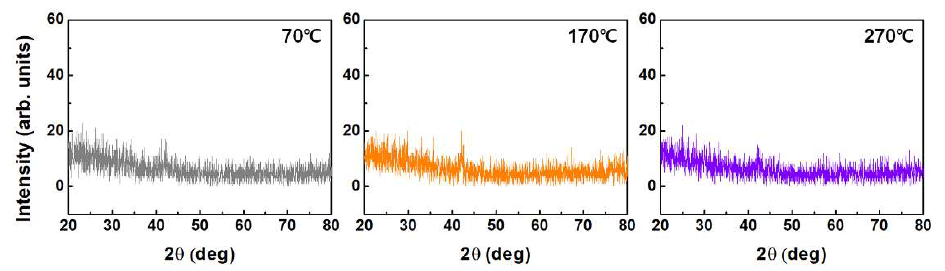
Figure 9. XRD graphs of the brush-coated LaYSrO films cured at 70, 170, and 270 ℃ .